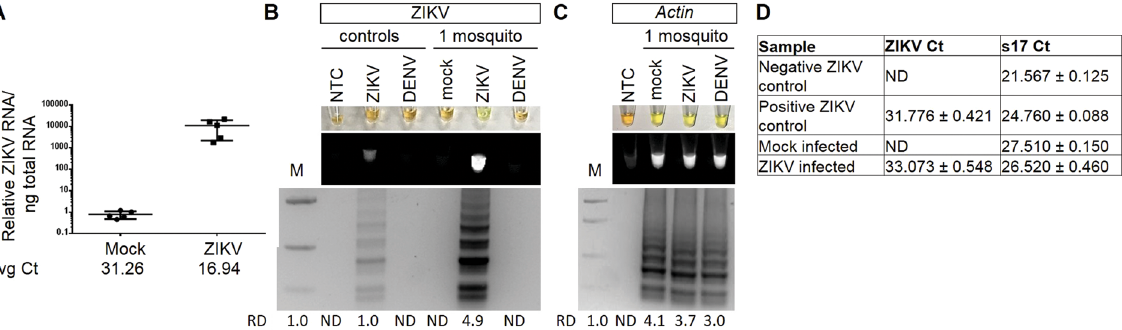
Figure 5. ZIKV and Actin detection in mosquitos. ( A ) qRT-PCR of ZIKV RNA normalized to total RNA for mock (n = 5) or ZIKV (n = 5) infected mosquitos. ( B , C ) Single mosquitos were infected with either mock, ZIKV, or DENV and subjected to a ZIKV ( B ) or Aedes aegypti Actin ( C ) specific RT-LAMP reaction then visualized by addition of SYBR Green I by eye (upper panel), green fluorescence (middle panel), or gel electrophoresis (bottom panel). Lane M: Low DNA Mass Marker (ThermoFisher Scientific); NTC: No template control (negative control). Relative density (RD) of the entire bands for a column relative to the DNA Mass Marker are indicated below the corresponding lane. Lanes that did not have any detectable bands over background are reported as not detectable (ND). ( D ) Detection of ZIKV or ribosomal s17 by qRT-PCR. Data shown as mean ± standard deviation.